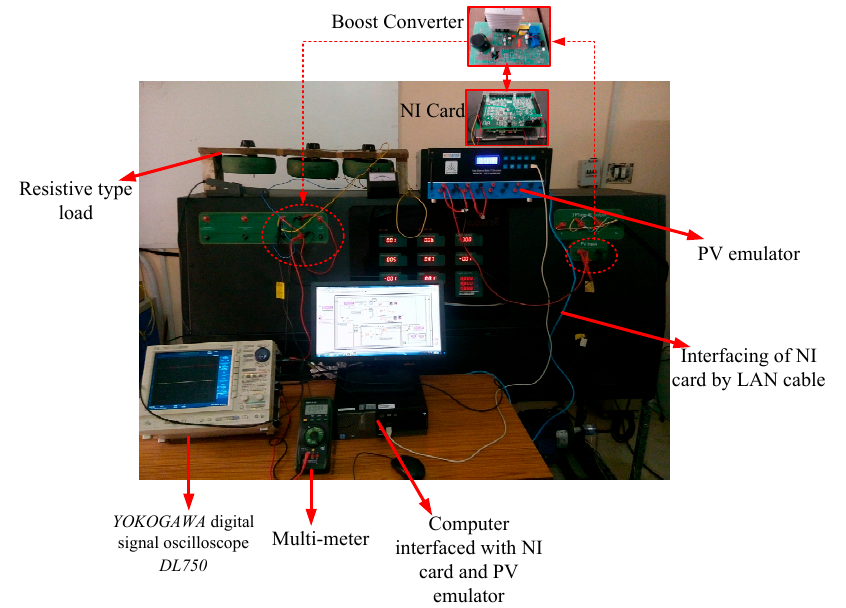
Figure 18. Complete setup of hardware implementation.